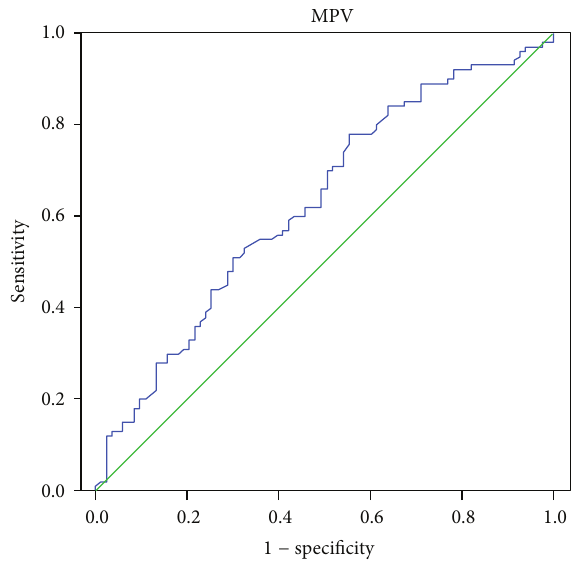
Figure 1: Receiver-operating characteristic curves for predictors of retinal vein occlusion. The MPV values area under the curve, 0.628; green